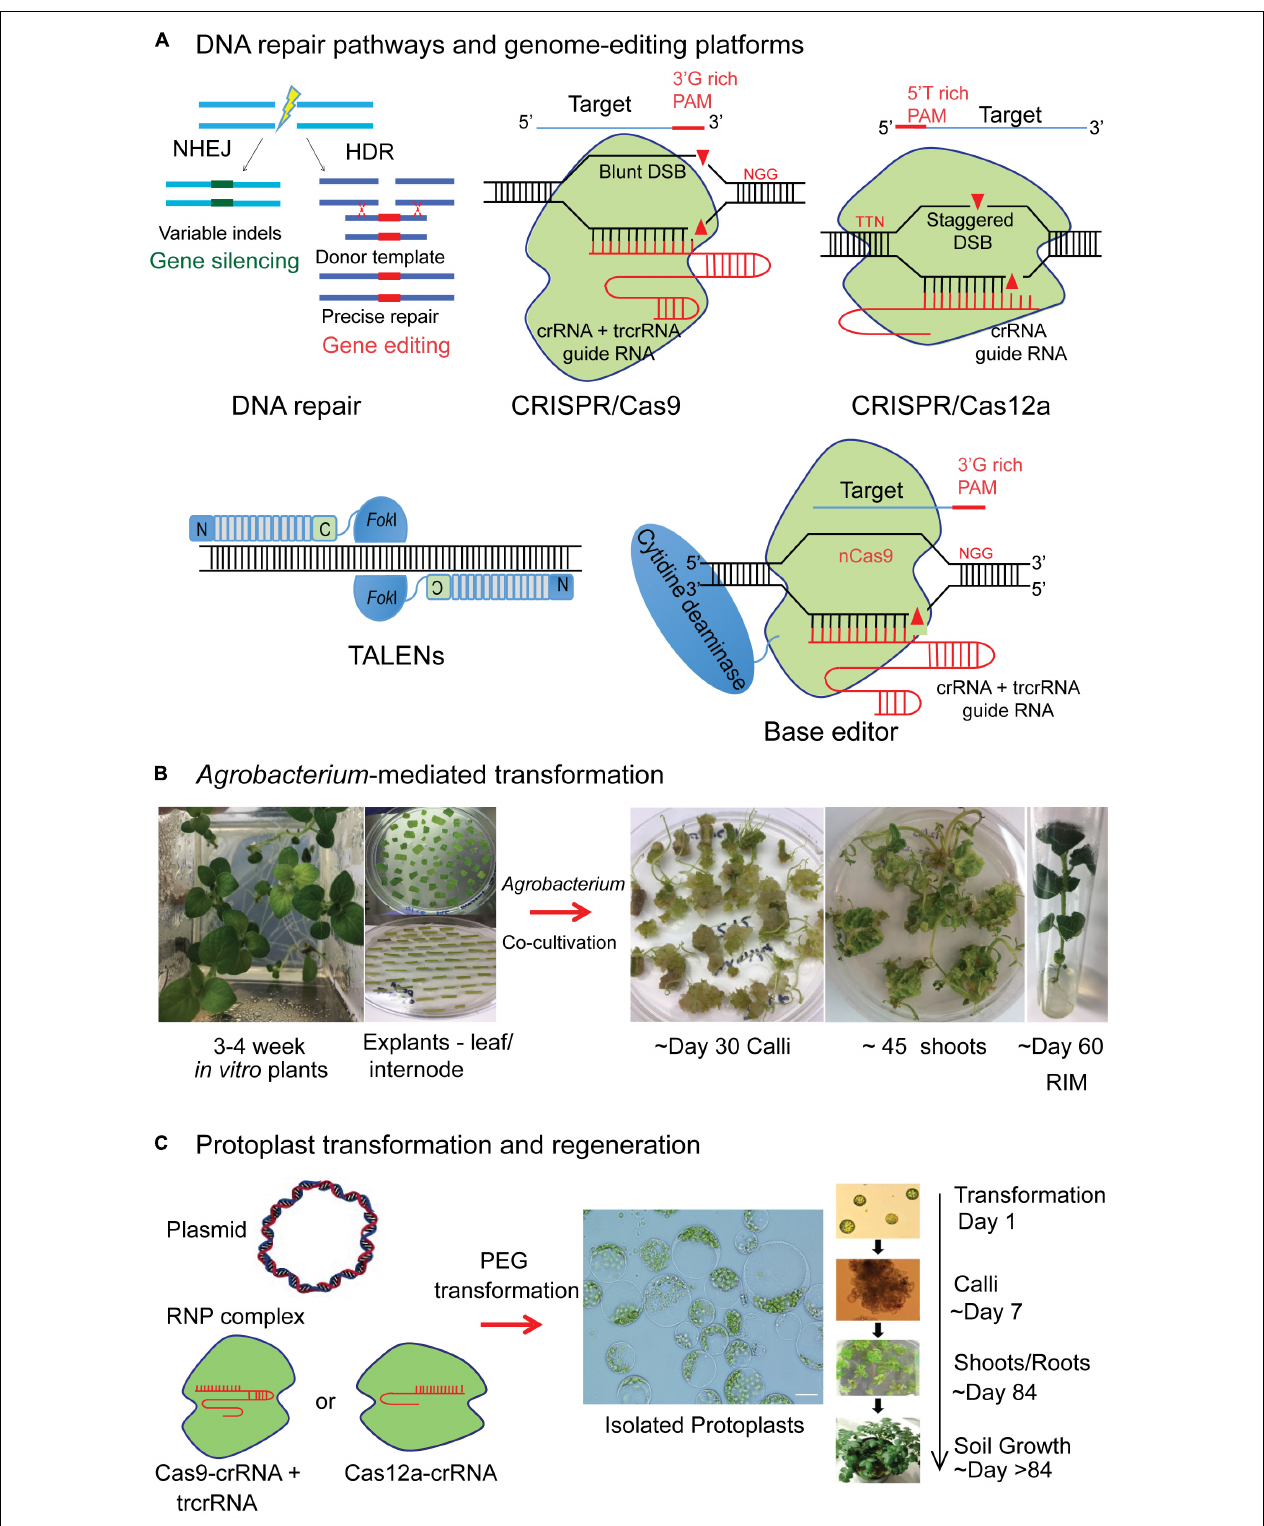
FIGURE 1 | Illustration of genome-editing platforms and genetic transformation procedures in potato. (A) Double stranded DNA (dsDNA) break repair in a cell occurs either by non-homologous end joining (NHEJ), where the cleaved DNA molecule is simply rejoined, often with indels in coding regions (green) that result in gene